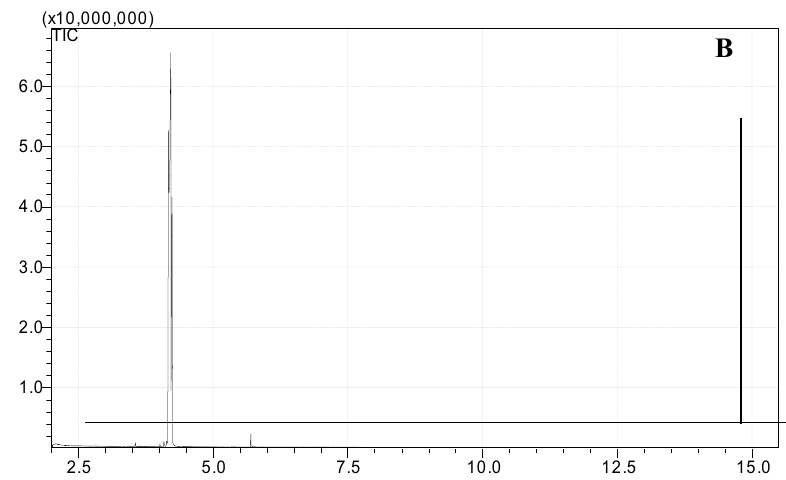
Figure 12. Total ion chromatogram (TIC) of standard mannose and date juice. For mannose, a peak